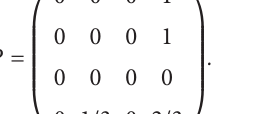
Figure 5: Pressure and flow data collection at 0.1 MPa leakage.